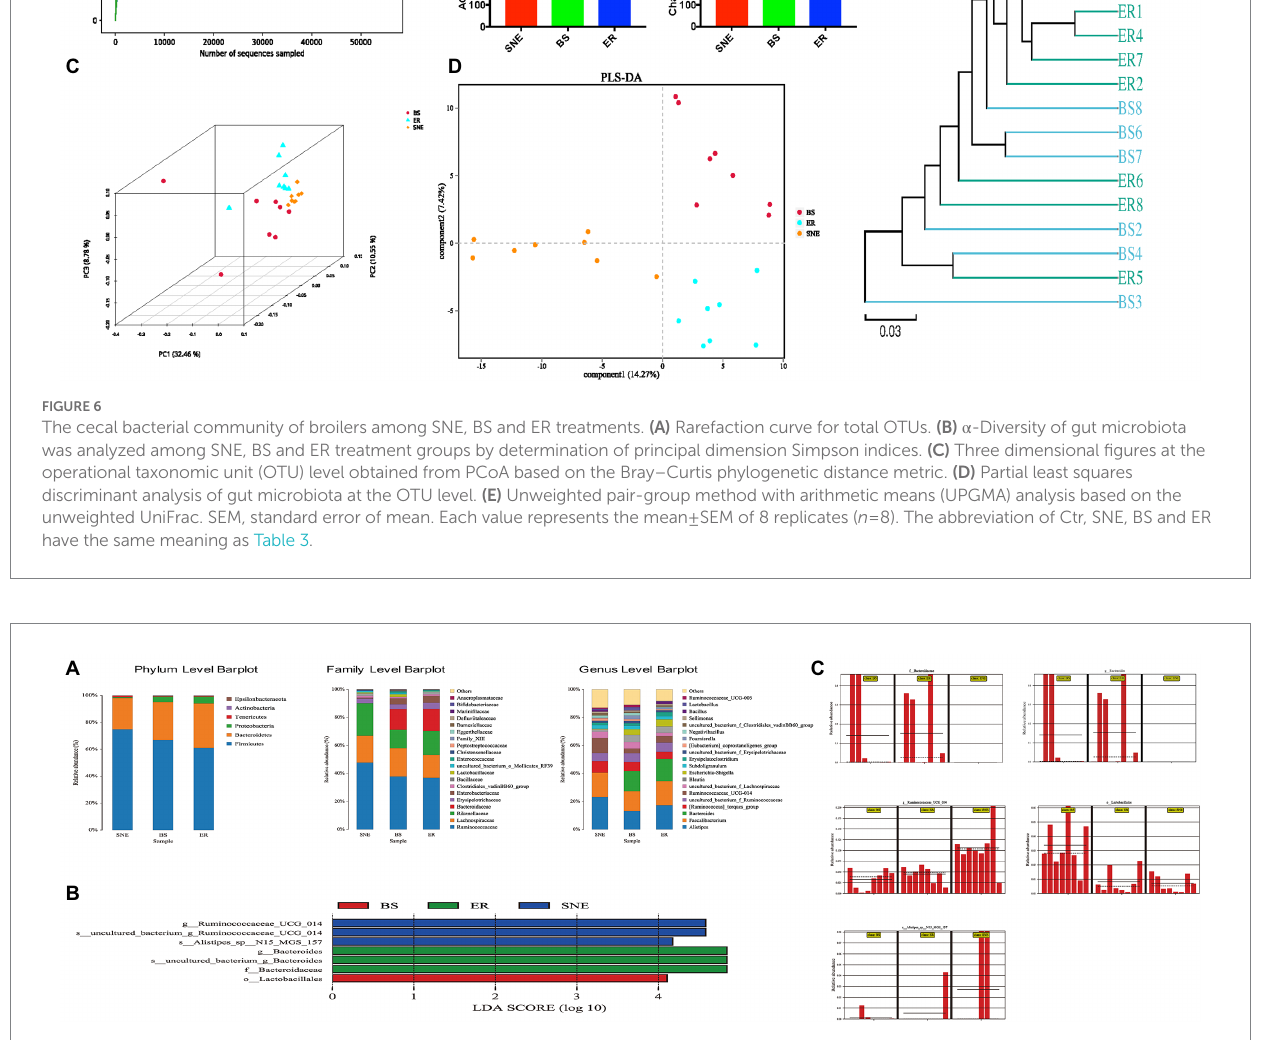
FIGURE 7 Structural changes in intestinal microbiota following dietary Bacillus subtilis DSM 29784 supplementation. (A) Relative abundance of microbial community in the cecum at the phylum, family, and genus levels. (B) LEfSe score plot of the discriminative microbial taxa (LDA score >4) that are more enriched in the BS (red), ER (green) and SNE (blue) groups. (C) Resulting bar plots display relative abundances of the phyla that are significantly altered, obtained from LEfSe analysis [o: order, f: family level, g: genus, s, species]. SEM, standard error of mean. Each value represents the mean ± SEM of 8 replicates ( n = 8). The abbreviation of Ctr, SNE, BS and ER have the same meaning as Table